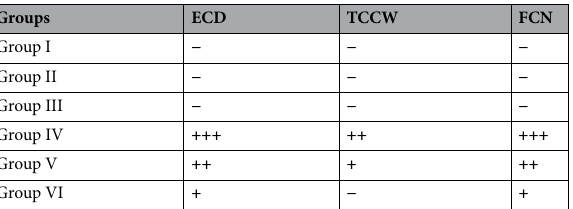
Table 3. Protective role of GSE against meristematic cell damage induced by KBrO 3 . Group I: Control, Group II: 465 mg/L GSE, Group III: 930 mg/L GSE, Group IV: 100 mg/L KBrO 3 , Group V: 100